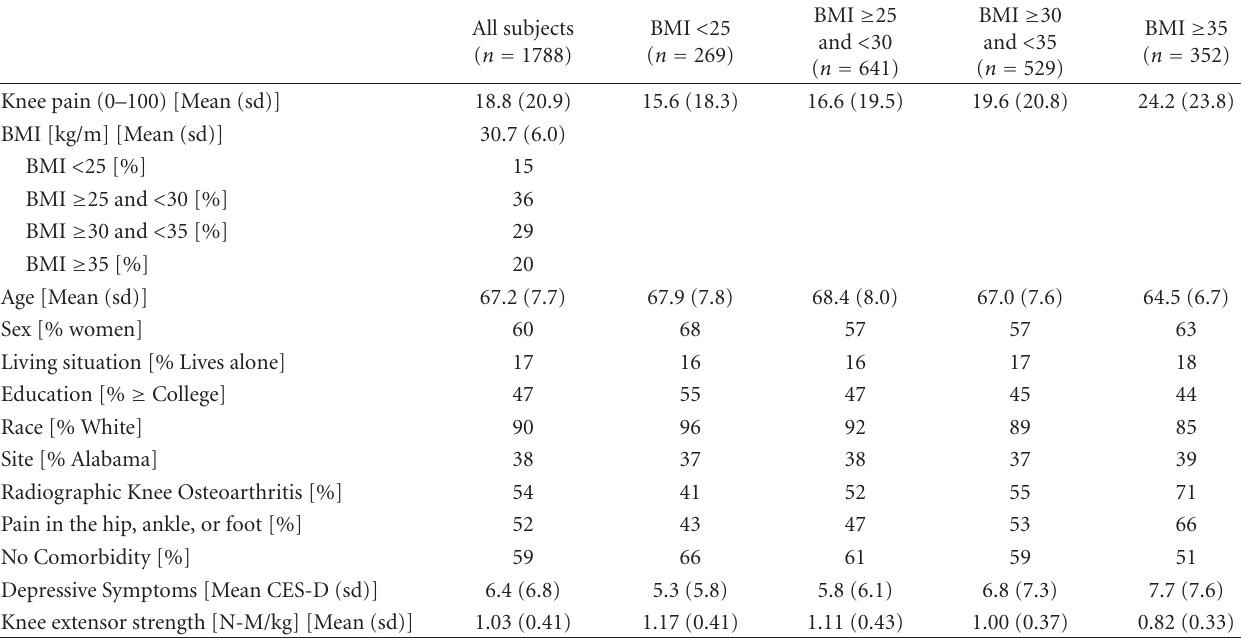
Table 1: Summary of baseline characteristics across all subjects and within BMI categories.